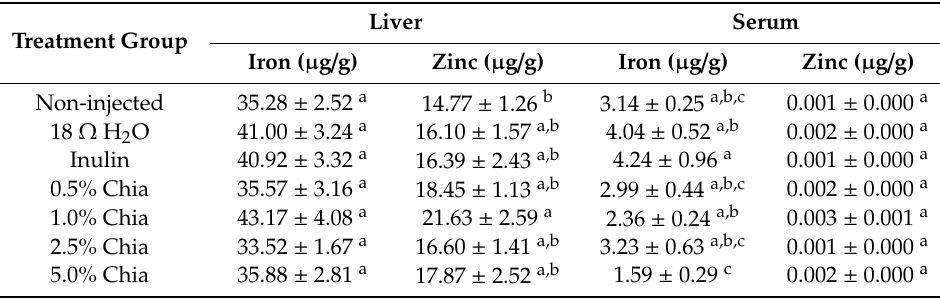
Table 5. Iron and zinc concentrations